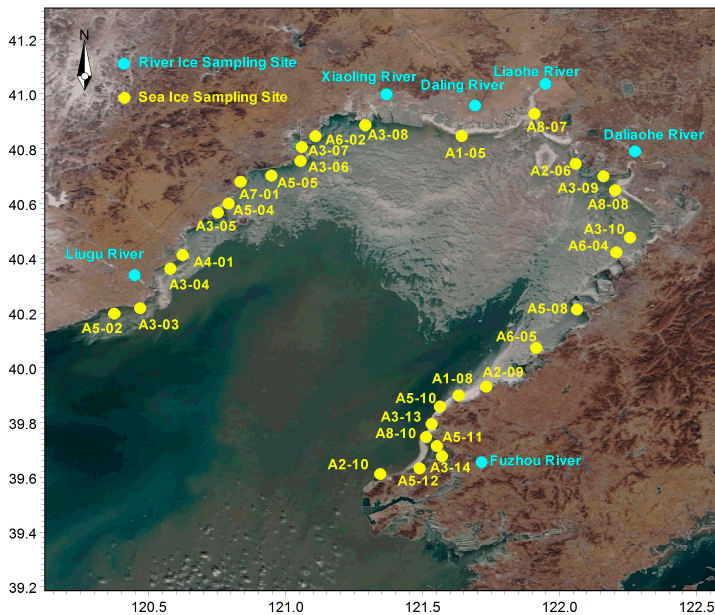
Figure 1. Sampling site in the coastal area of Liaodong Bay.